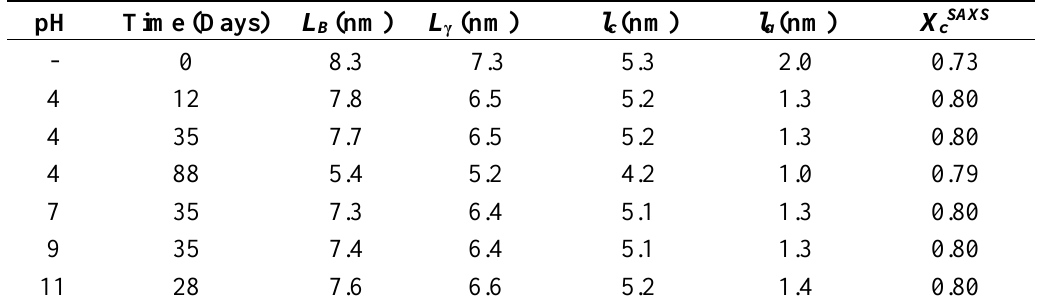
Table 1. Morphological parameters of γ irradiated GL- b -[GL- co -TMC- co -CL]- b -GL samples during degradation in the indicated degradation media and exposure